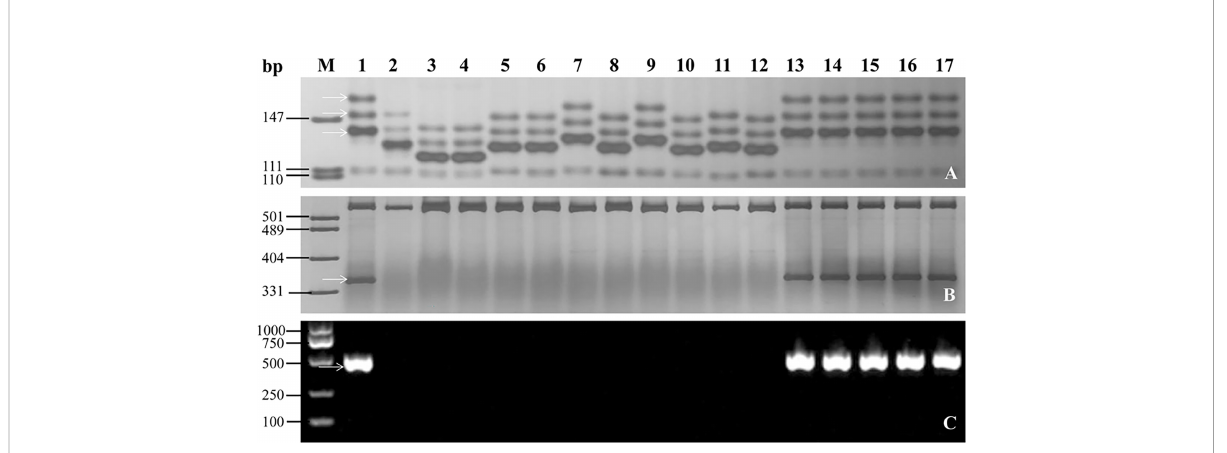
FIGURE 6 Ampli fi cation patterns of the fl anked markers GDM93 (A) and WGRC763 (B) and the co-segregated marker BCD1231 (C) of PmYAV in YAV249, Shixin 828 and selected wheat cultivars/lines. M: pUC19/ Msp I; 1: YAV249; 2: Shixin 828; 3: Shi 4185; 4: Shiyou 17; 5: Shimai 18; 6: Shixin 633; 7: Ji 5265; 8: Kenong 199; 9: Zhengyumai 9989; 10: Zhou 16; 11: Jinmai 41; 12: Gaoyou 503; 13: Xinmai 1998; 14: ROANE; 15: Safha 3; 16: Aikang 58; 17: Taixue 12. The white arrows indicate the speci fi c ampli fi ed